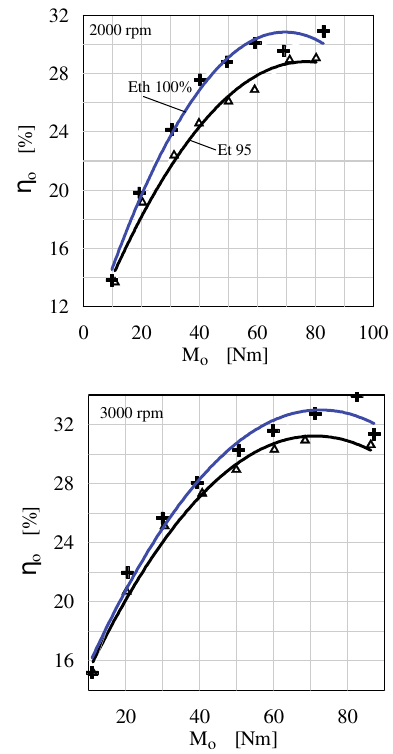
Fig. 3. Comparison of overall efficiency of the Fiat 1100 MPI engine fueled with Et 95 gasoline and ethyl Eth 100%